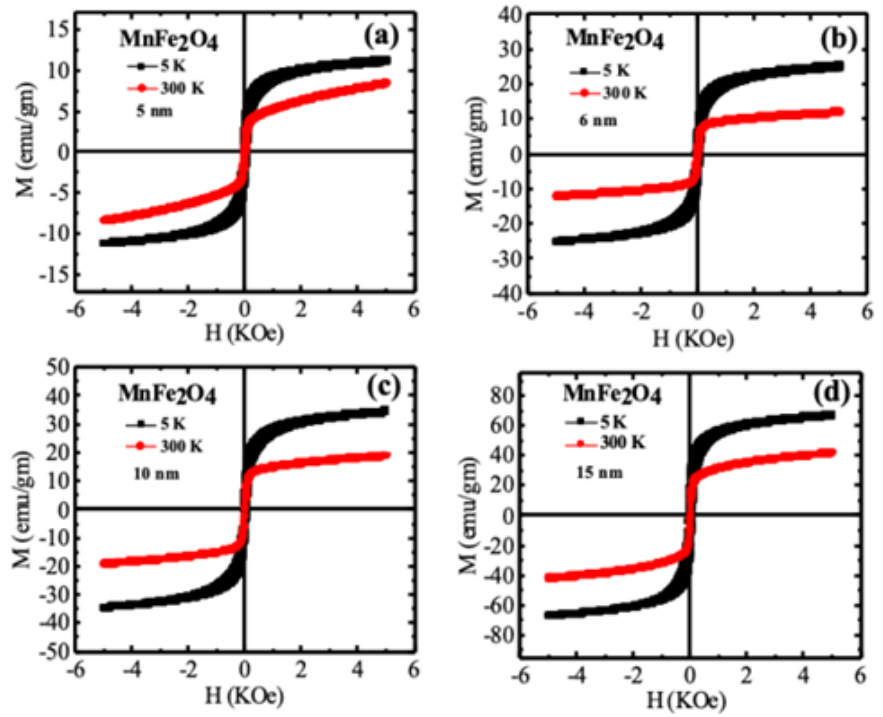
Figure 4. M-H hysteresis loops of MnFe 2 O 4 nanoparticles in the as-dried condition measured at 5 and 300 K with a maximum applied field of 5 Tesla. The M-H loops of the MnFe 2 O 4 nanoparticles at di ff erent pH are presented, ( a ) 5 nm, ( b ) 6 nm, ( c ) 10 nm, and ( d ) 15